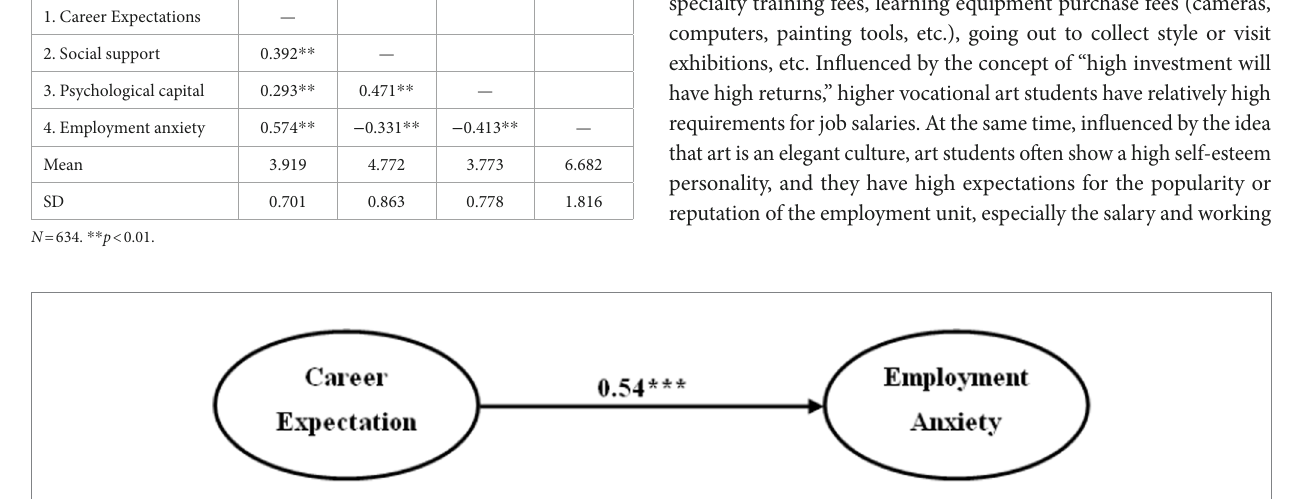
FIGURE 2 Main effect of career expectation to employment anxiety. *** p < 0.001.